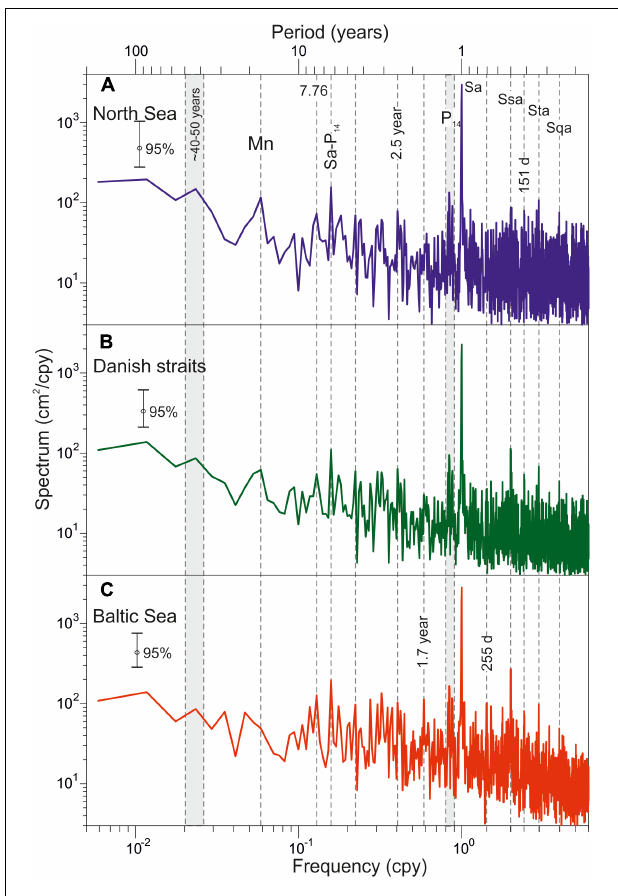
FIGURE 2 | The low-frequency sea level spectra estimated from mean monthly sea level records in (A) the North Sea, (B) the Danish straits, and (C) the Baltic Sea. Labels “Mn,” “Sa,” “Ssa,” “Sta,” “Sqa,” and “P 14 ” mark nodal, annual, semiannual, terannual, quartoannual, and 14-month spectral peaks,